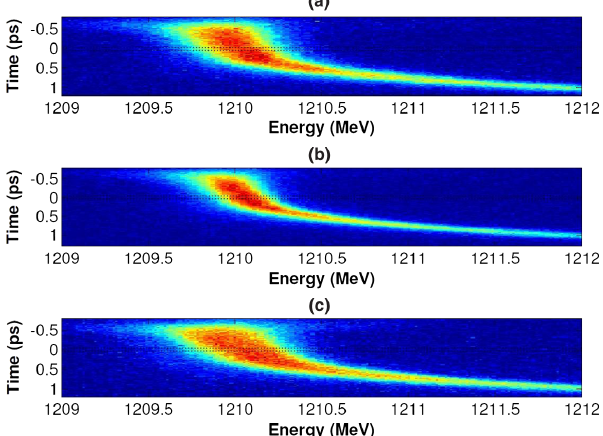
FIG. 13. Beam longitudinal phase space at the end of the linac for three settings of the laser heater resulting in calculated heating values (before bunch length compression) of 4.5 keV (top panel), 10.5 keV (middle) and 29.5 keV (bottom) (rms). These are uncom- pressed values, relevant upstream of BC1. During these measure- ments the LH laser spot was reduced to 130 × 130 μ m 2